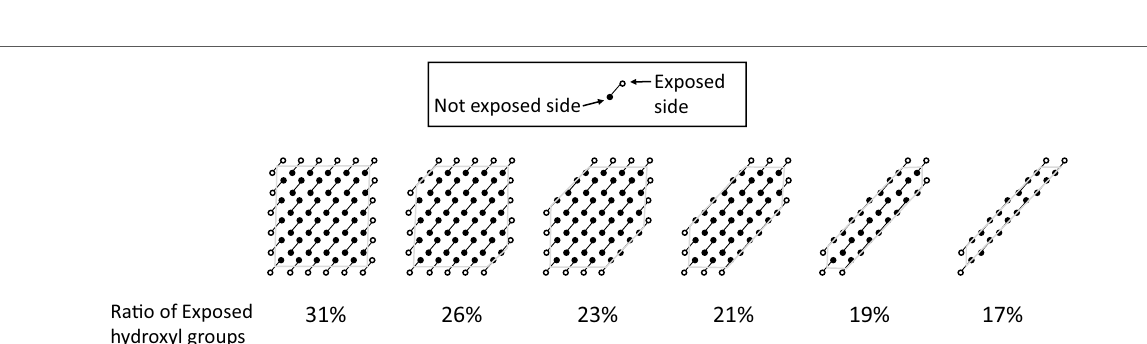
Fig. 8 Cellulose microfibril cross-section with the exposed hydroxyl group ratio. Open circles are exposed sides of cellulose molecular chains, and filled circles are non-exposed sides of cellulose molecular chains